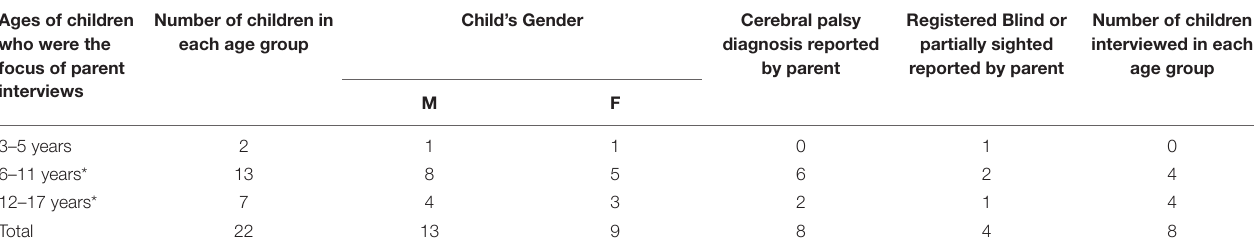
Child’s Gender Cerebral palsy